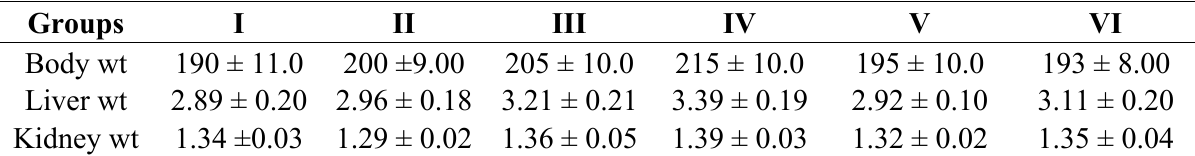
Table 1. Effects of CuLBS on body and organ